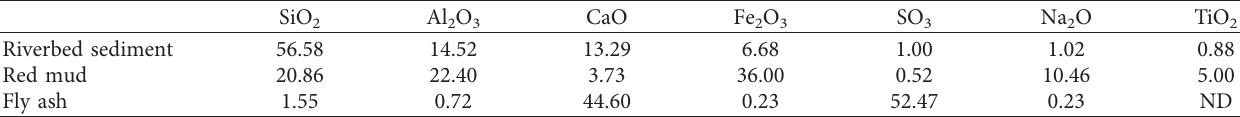
Table 1: Chemical compositions of raw materials (% by mass).